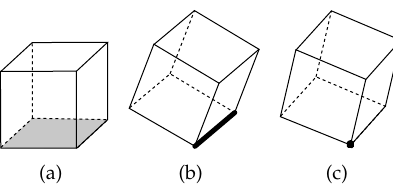
Figure 5. Three types of principal contacts (PCs) that a robot cannot access regardless of the object’s configuration: ( a ) ( face,face ) e ; ( b ) ( edge,face ) e ; and ( c ) ( vertex,face ) e